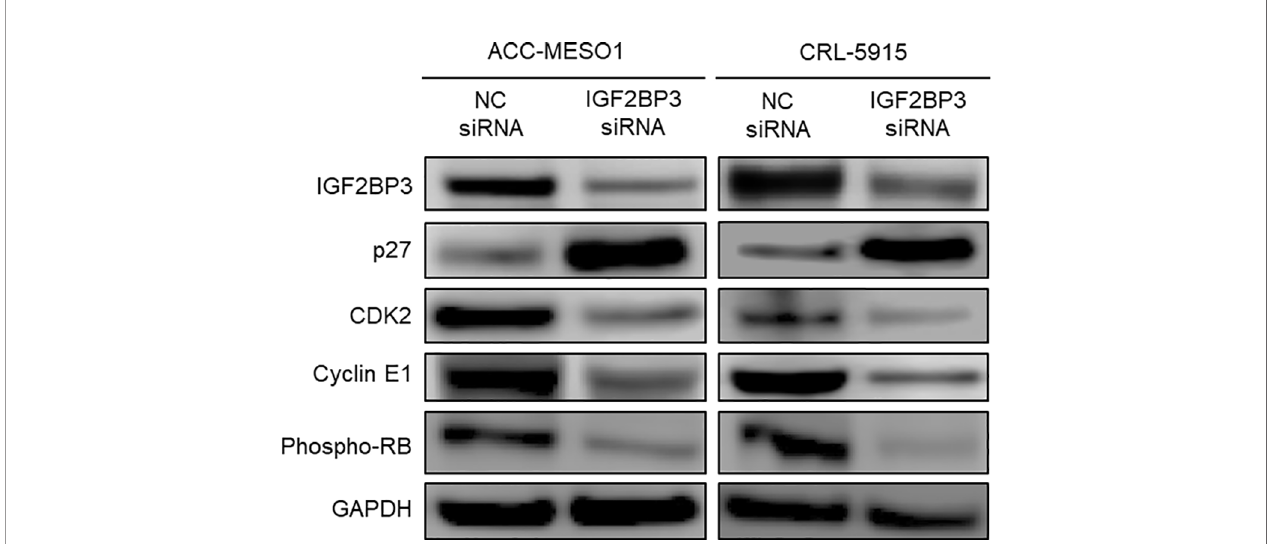
FIGURE 4 | Downstream regulation of IGF2BP3. Western blots of IGF2BP3, p27, CDK2, Cyclin E1, and phospho-RB proteins in ACC-MESO1 and CRL-5915 cells show increased expression of p27 and decreased expression of CDK2, Cyclin E1, and phospho-RB with IGF2BP3 siRNA transfection. NC: negative